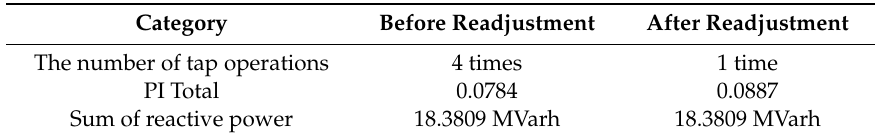
Table 10. Comparison of the number of tap operations, PI total, sum of reactive power with / without proposed method of case 2 for